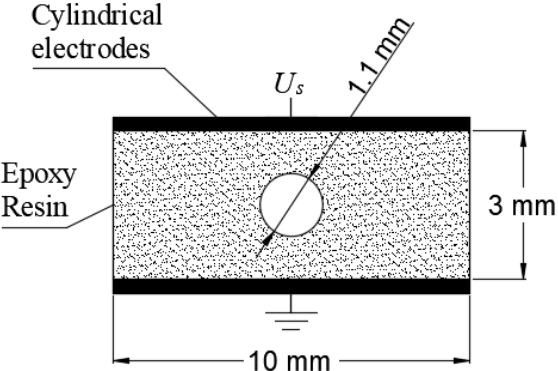
Figure 6. Geometry of the case study. A spherical void with 1.1 mm in diameter immersed in an epoxy-resin dielectric bulk between two parallel plates.